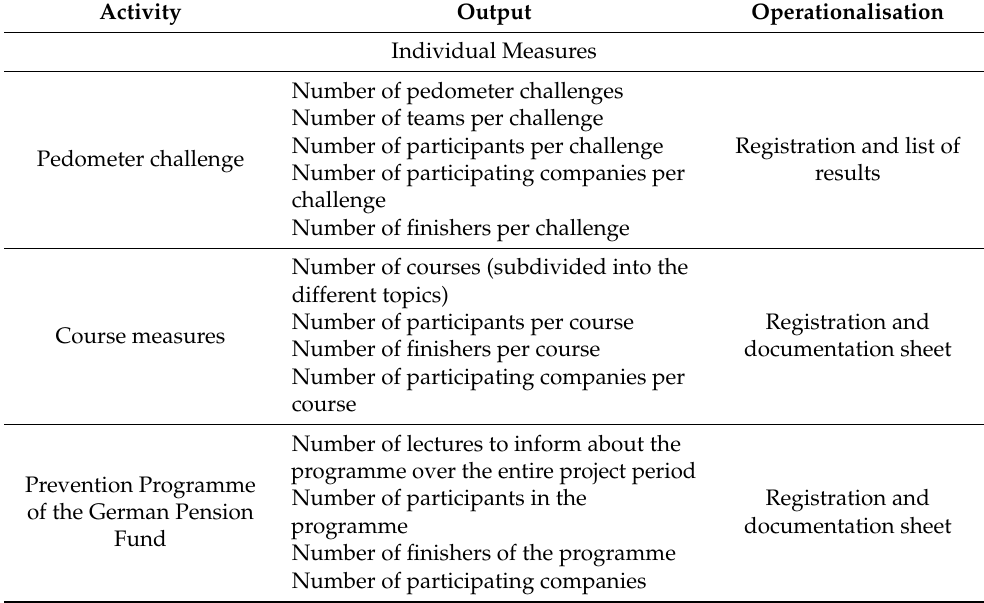
Table 1. Output and operationalisation of specific behavioural measures of the KomRueBer